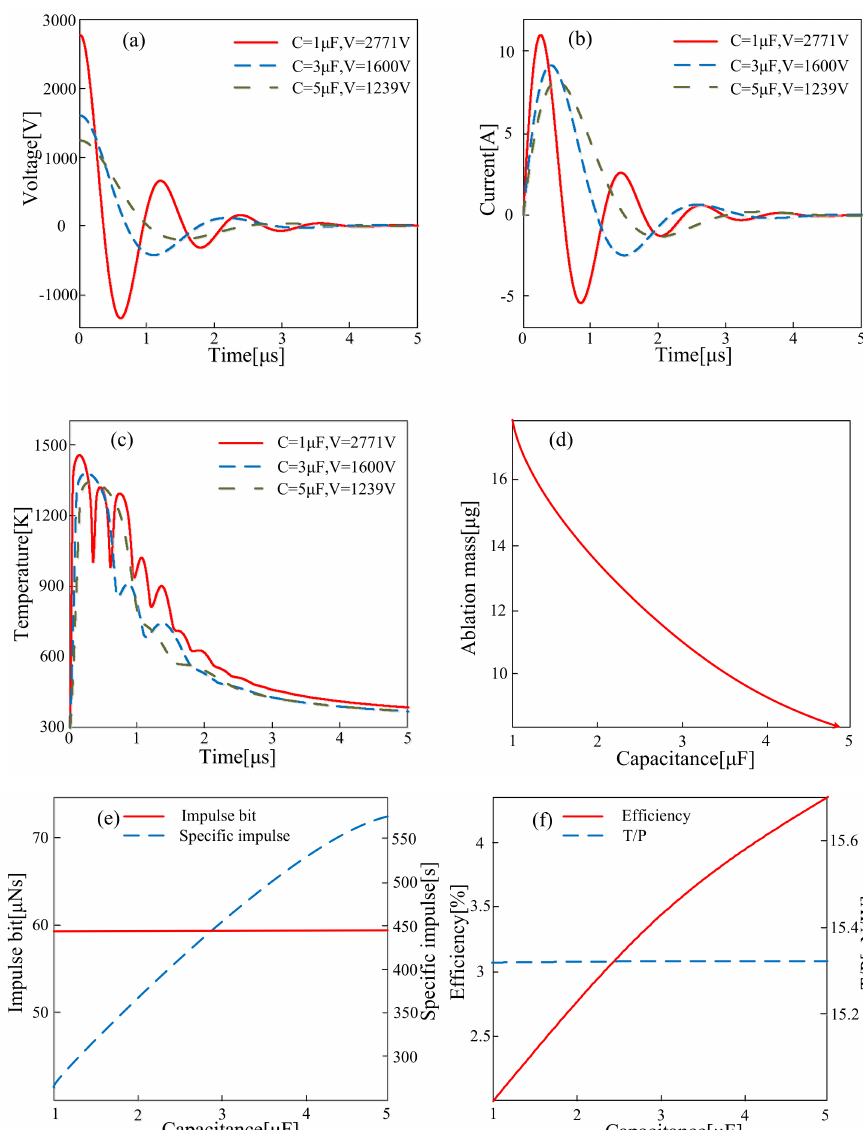
Figure 9. Simulation results at different capacitance–initial voltage ratios: ( a ) Discharge voltage waveform; ( b ) discharge current waveform; ( c ) variation of ablation surface temperature of with time; ( d ) variation of ablation mass with capacitance; ( e ) variation of impulse bit and specific impulse with capacitance; and ( f ) variation of efficiency and ratio of thrust to power with